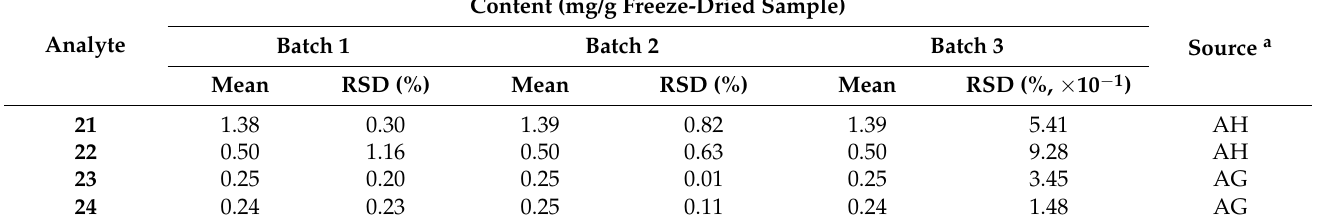
Figure S2: HPLC chromatogram of the herbal medicine extract and its main components. (A): A. con- tinentalis ; (B): A. gigas ; (C), P. lactiflora ; (D), T. chinensis ; (E), R. glutinosa ; (F), C. officinale ; (G), P. ginseng ; (H), P. cocos ; (I), A. bidentata ; (J), E. ulmoides ; (K), G. straminea ; (L), A. heterotropoides ; (M), S. divaricate ; (N), C. cassia ; (O), G. uralensis ; and (P), Z. officinale ; Figure S3: HPLC chromatograms of the standard solution (A) and 70% methanol of DHGST sample (B). Gallic acid ( 1 ), 5-hydroxymethylfurfural ( 2 ), geniposidic acid ( 3 ), loganic acid ( 4 ), cimufugin ( 5 ), chlorogenic acid ( 6 ), geniposide ( 7 ), gentiopi- croside ( 8 ), pinoresinol diglucoside ( 9 ), albiflorin ( 10 ), prim - O -glucosylcimifugin ( 11 ), paeoniflorin